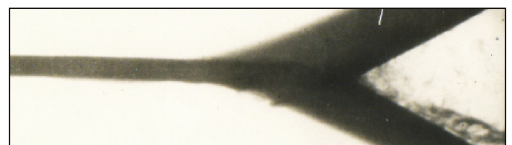
Figure 5: X-ray photograph of copper plate colliding with different velocities (the upper plate at a velocity ] 𝑛2 = 1.26 km/s and the lower plate at a velocity ] 𝑛1 = 1.12 km/s) [15].